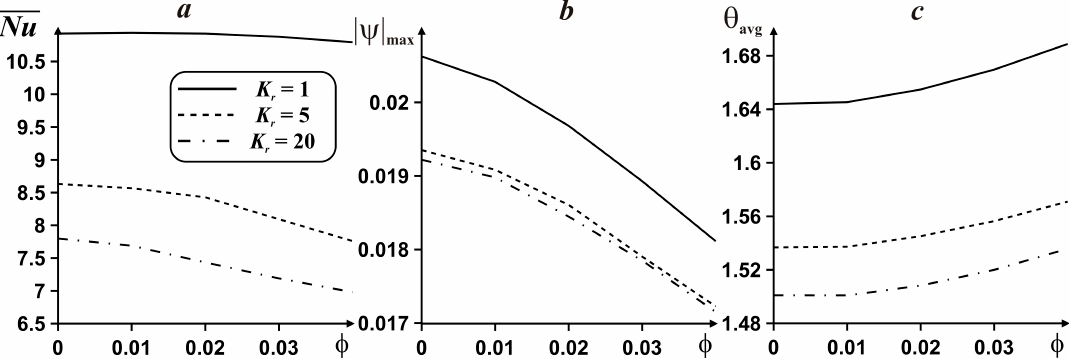
Figure 8. Dependences of the average Nusselt number ( a ), nanoliquid circulation rate ( b ) and mean heater temperature ( c ) on φ and K r for Ra = 10 5 , δ = 0.2.